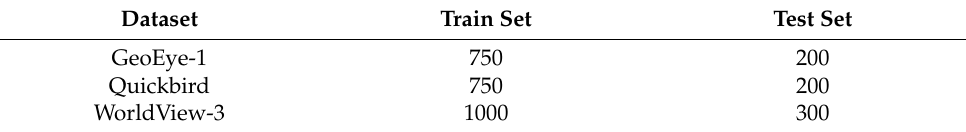
Table 2. The spatial resolution of datasets from different satellites. Dataset Train Set Test